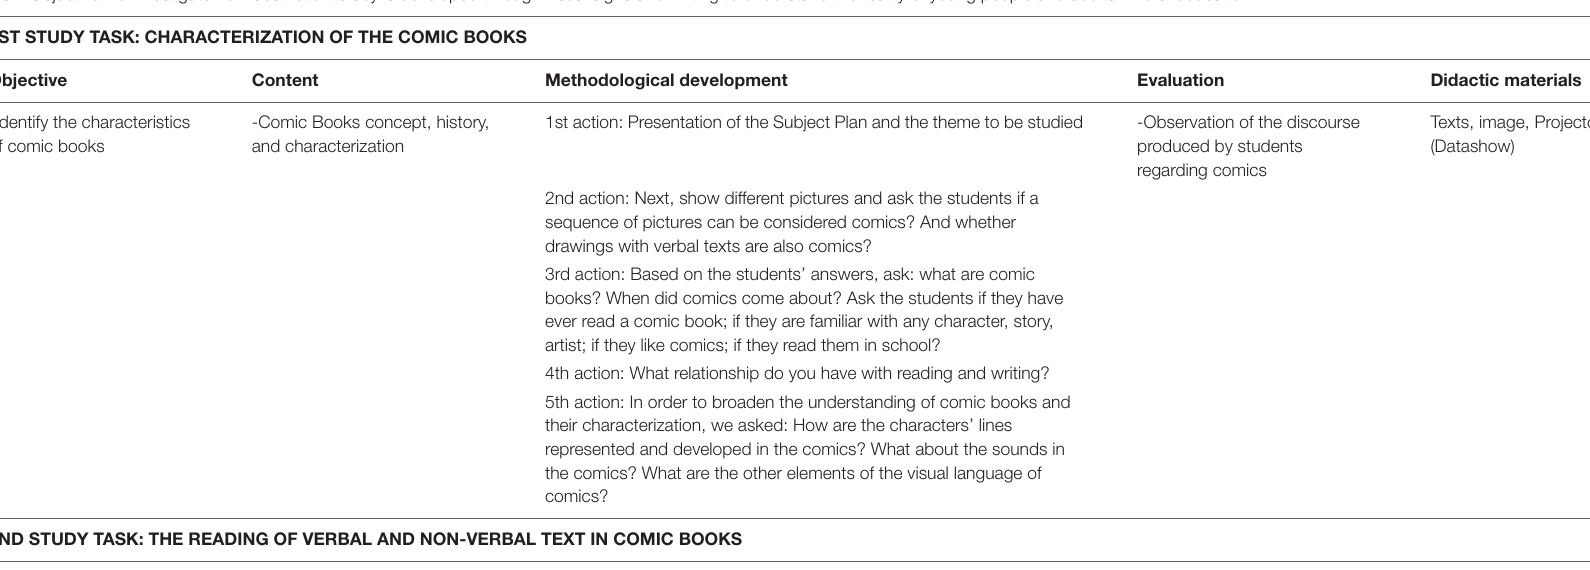
TABLE 2 | Experimental didactic